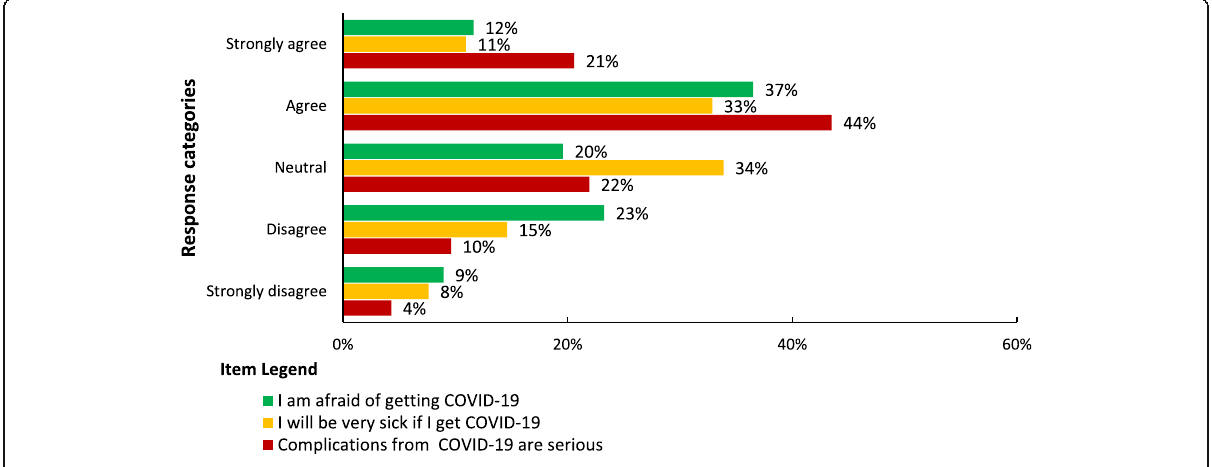
Fig. 3 Perceived seriousness of COVID-19 among school teachers in Gondar city, Northwest Ethiopia (n = 301)